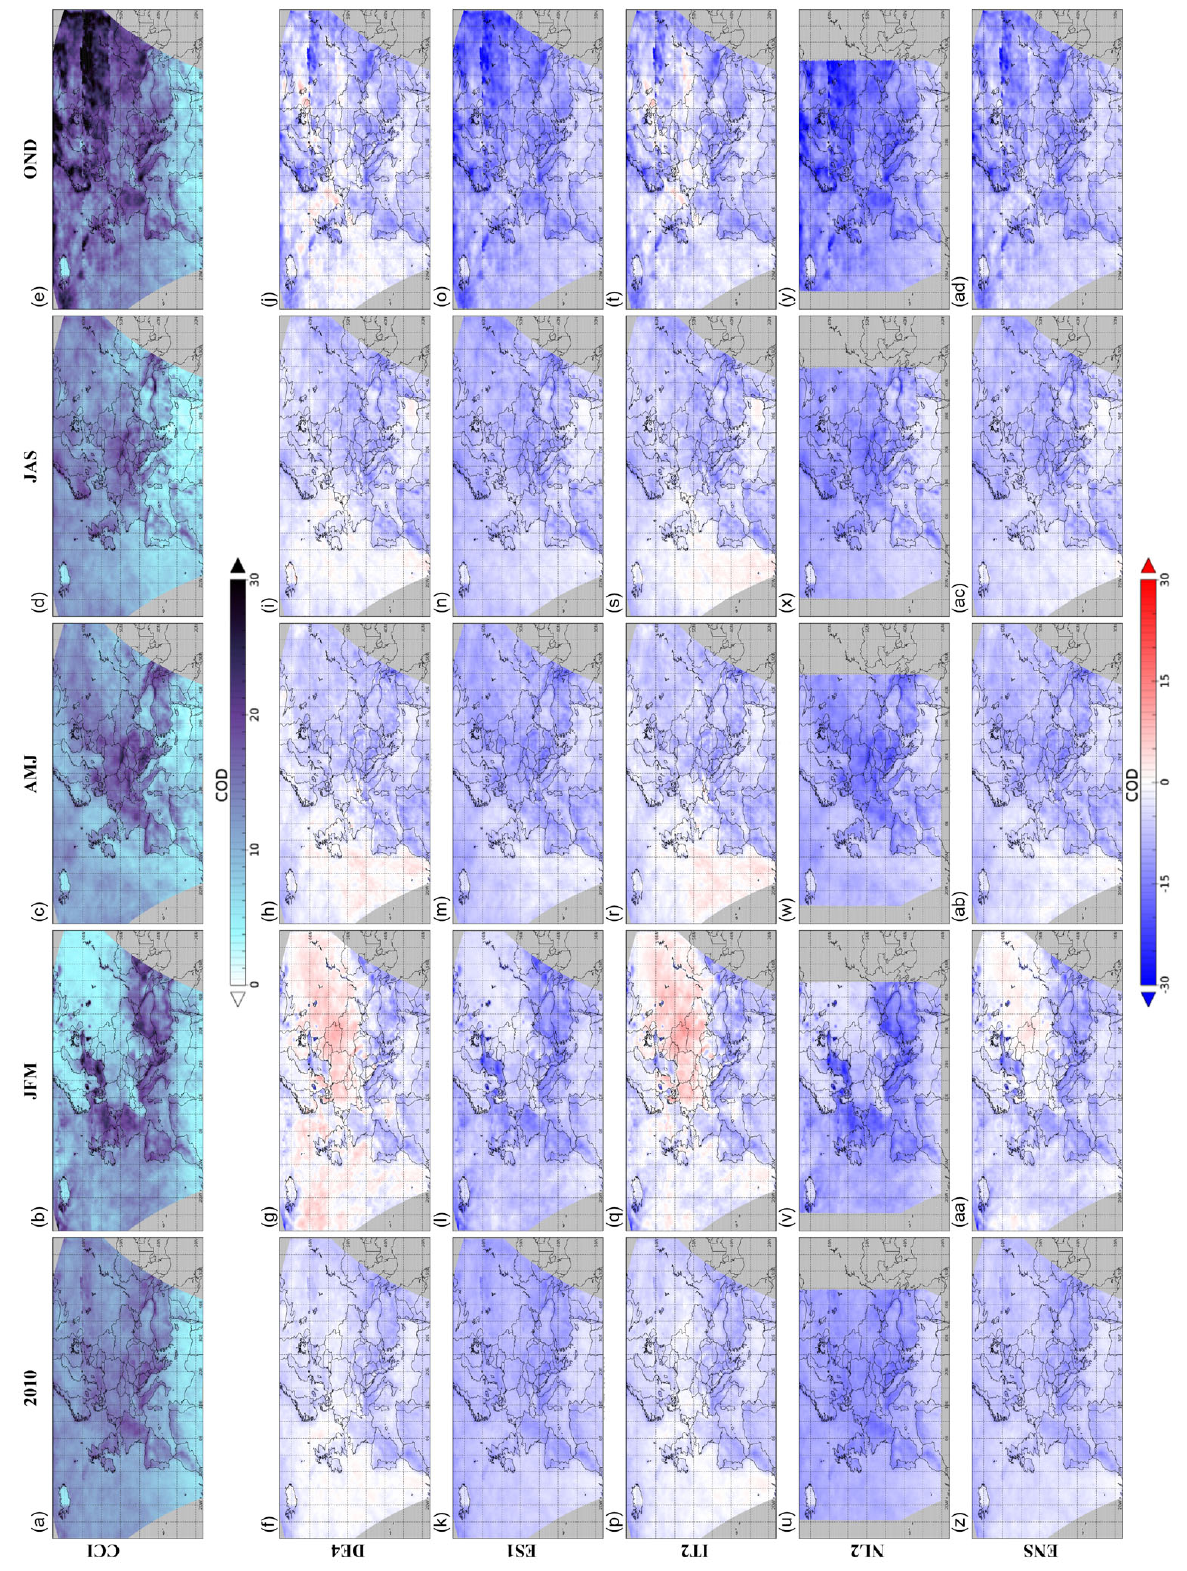
Figure 5. Same as Fig. 1 for the COD and mean bias error